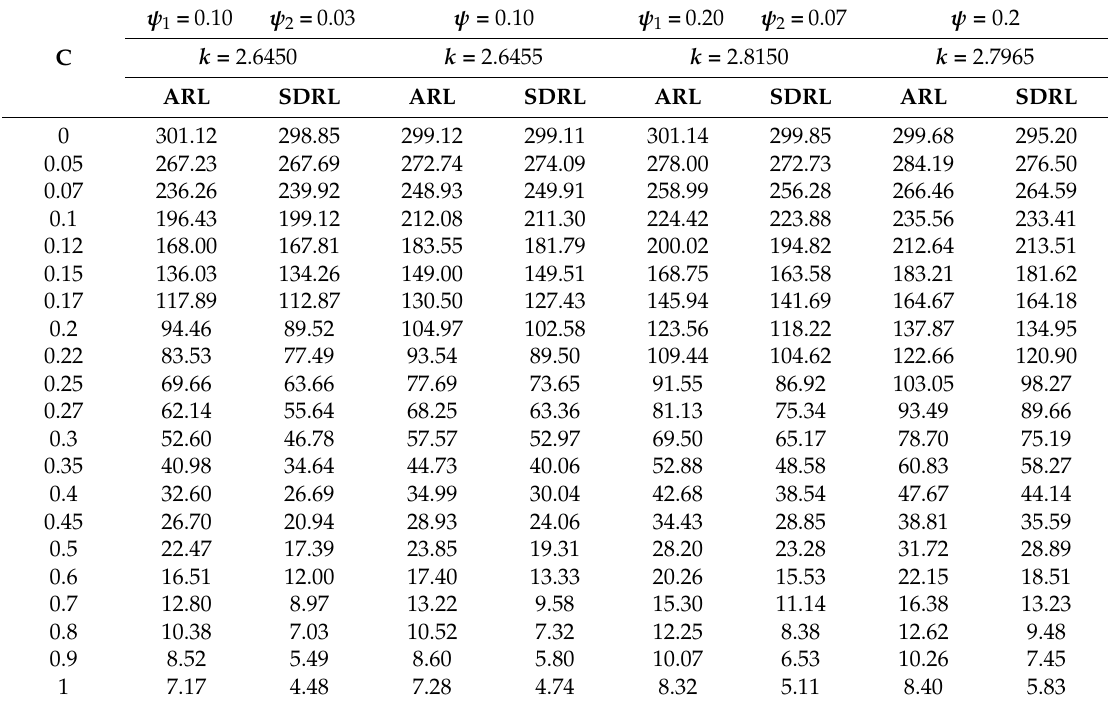
Table 5. The ARL, SDRL values of the proposed EEWMA and EWMA control charts for various shifts when r 0 =